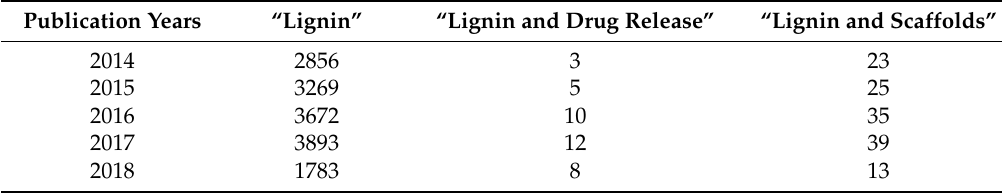
Table 1. Number of scientific publications on “lignins” refined by “lignin in drug release” and “lignin scaffolds” according to Web of Science, searched on 20 June 2018.